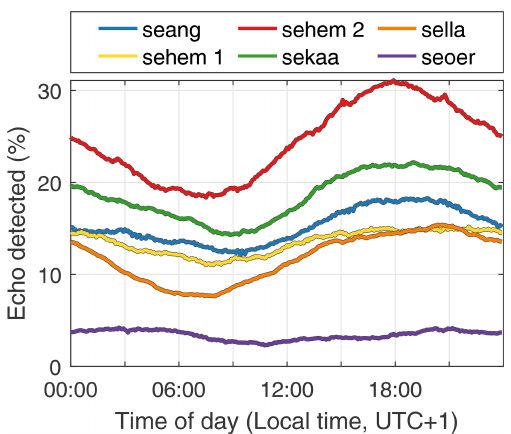
Figure 8. Relative frequency of detected echoes from all the se- lected groups of radar cells as a function of the time of day.